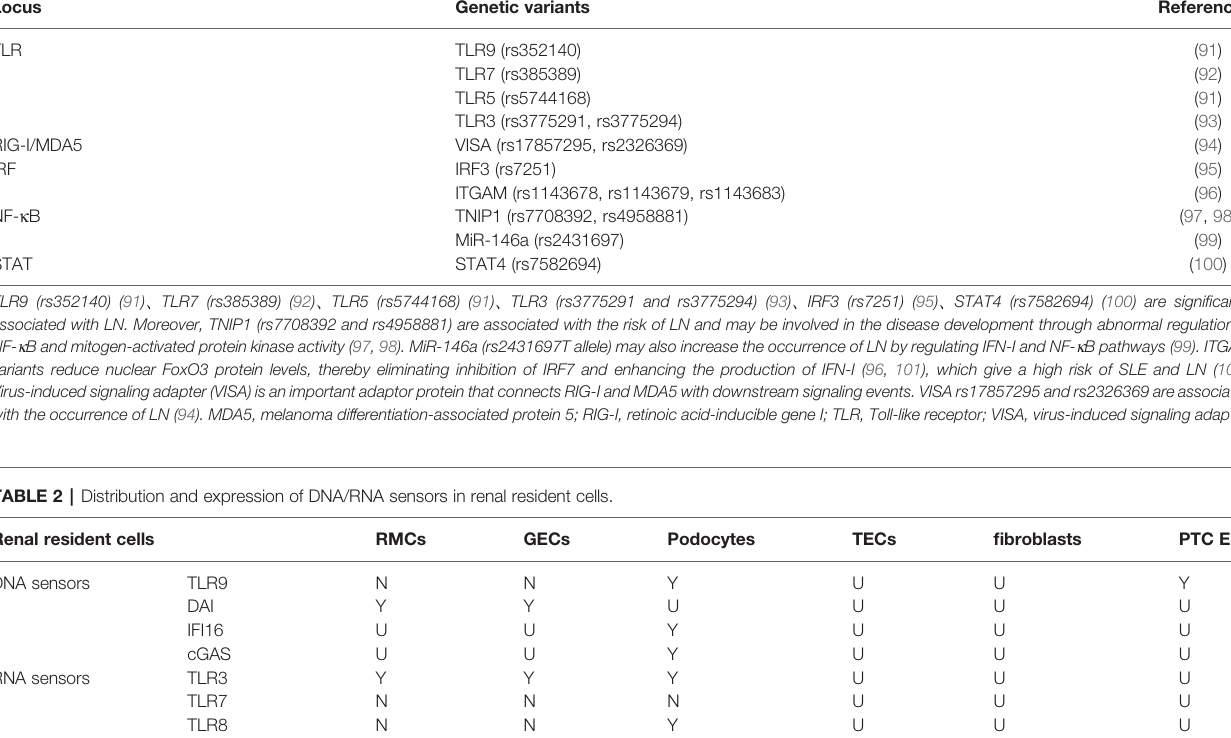
TABLE 1 | Genetic variants in the DNA/RNA-IFN signaling pathway that contributes to the progression of LN. Locus Genetic